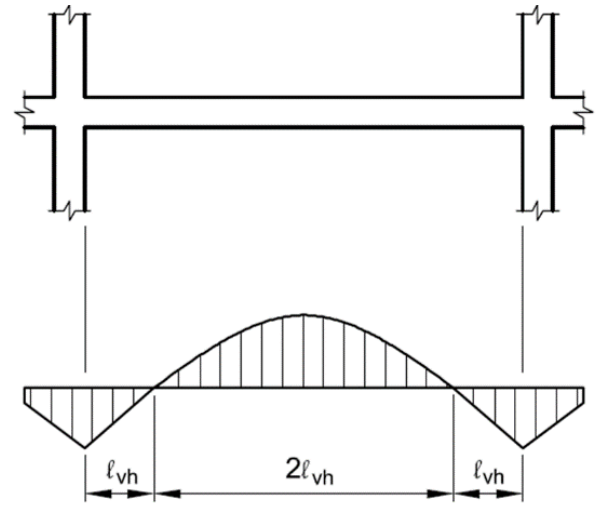
Figure 2. Horizontal shear transfer length (l vh ).